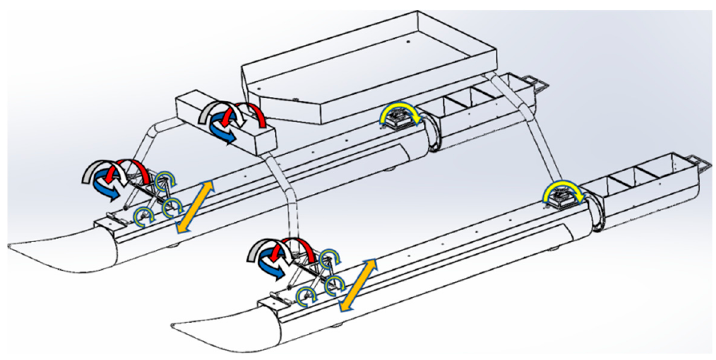
Figure 5. Degrees of freedom and constraints of the rescue vessel.